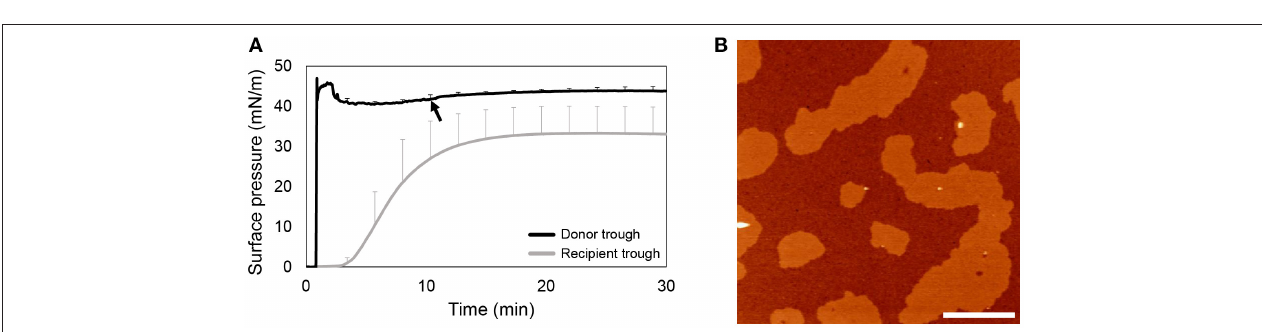
FIGURE 4 | rhSP-D association to the interface in the absence of surfactant-associated reservoirs. (A) Spreading isotherm of OE in organic solvent in a double-Langmuir balance and (B) AFM height image obtained from the transference of the recipient interfacial film after the spreading of 360 µ g of OE in organic solvent and the injection of 5% w/w rhSP-D 10min after (black arrow in A ). Three replicates were performed to obtain mean and standard deviation data.